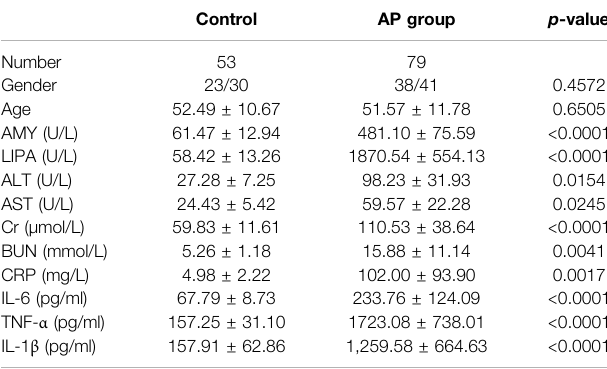
Abbreviation: AMY, amylase; LIPA, lipase; ALT, alanine amiotransferase; AST, aspartate amiotransferase; Cr, creatinine; BUN, blood urea nitrogen; CRP, C-creative protein; IL, interleukin; TNF, tumor necrosis